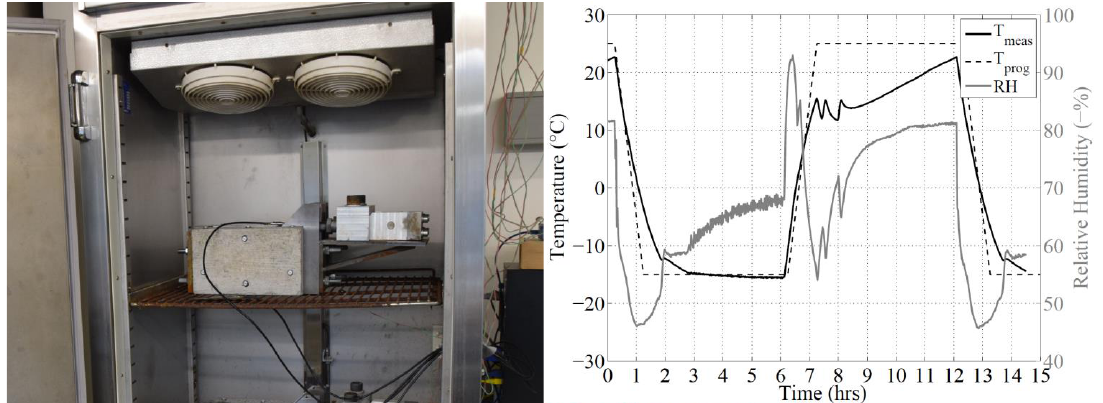
Figure 5. Left : FTC chamber employed within this study; right : programmed temperature, measured temperature and measured RH for one cycle, adopted from